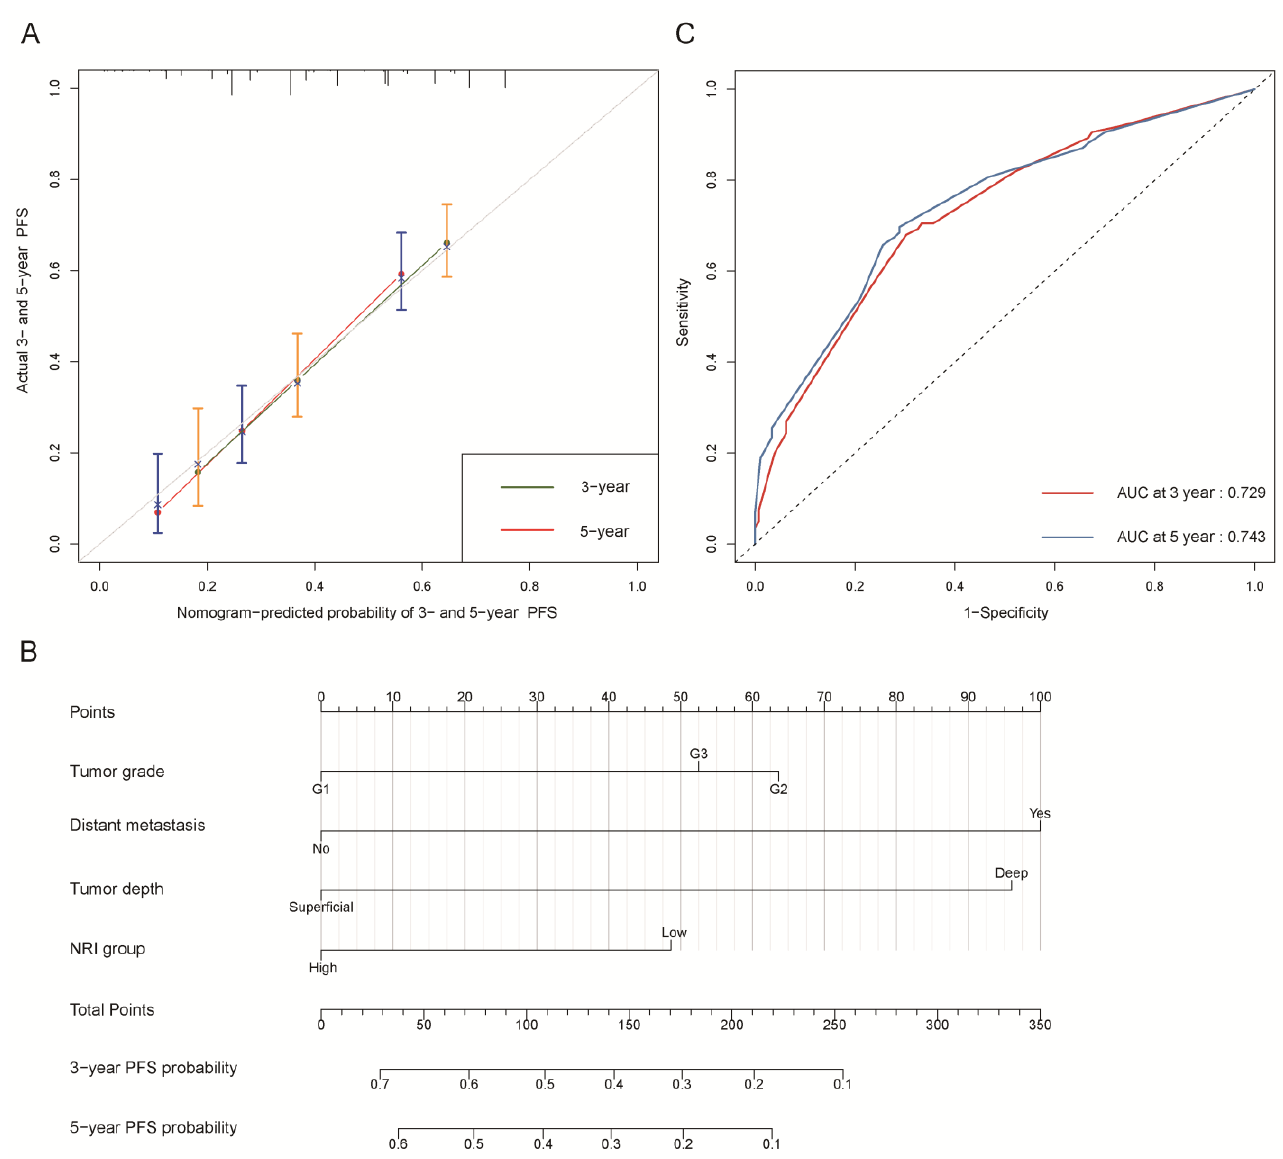
Figure 3. Progression-free survival (PFS). ( A ) Calibration plot of PFS at 3- and 5-year. ( B ) Nomogram for predicting the probability of PFS at 3- and 5-year. ( C ) Predictive performance of nomogram for PFS at 3-year and 5-year, by time-dependent receiver operating characteristic (ROC) curve analysis. The nomogram was constructed by tumor grade, distant metastasis, tumor depth, and NRI group. NRI group: low group (NRI ≤ 99.34) and high group (NRI > 99.34).